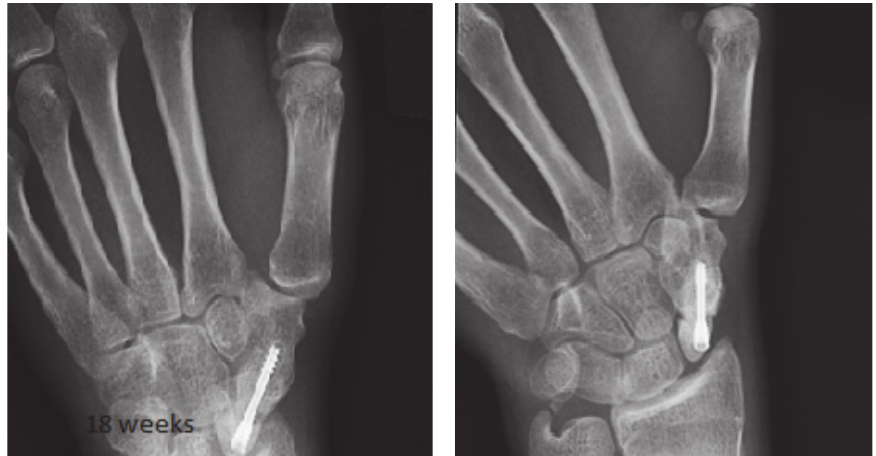
Figure 3: Radiographs show fracture fixation 18 weeks